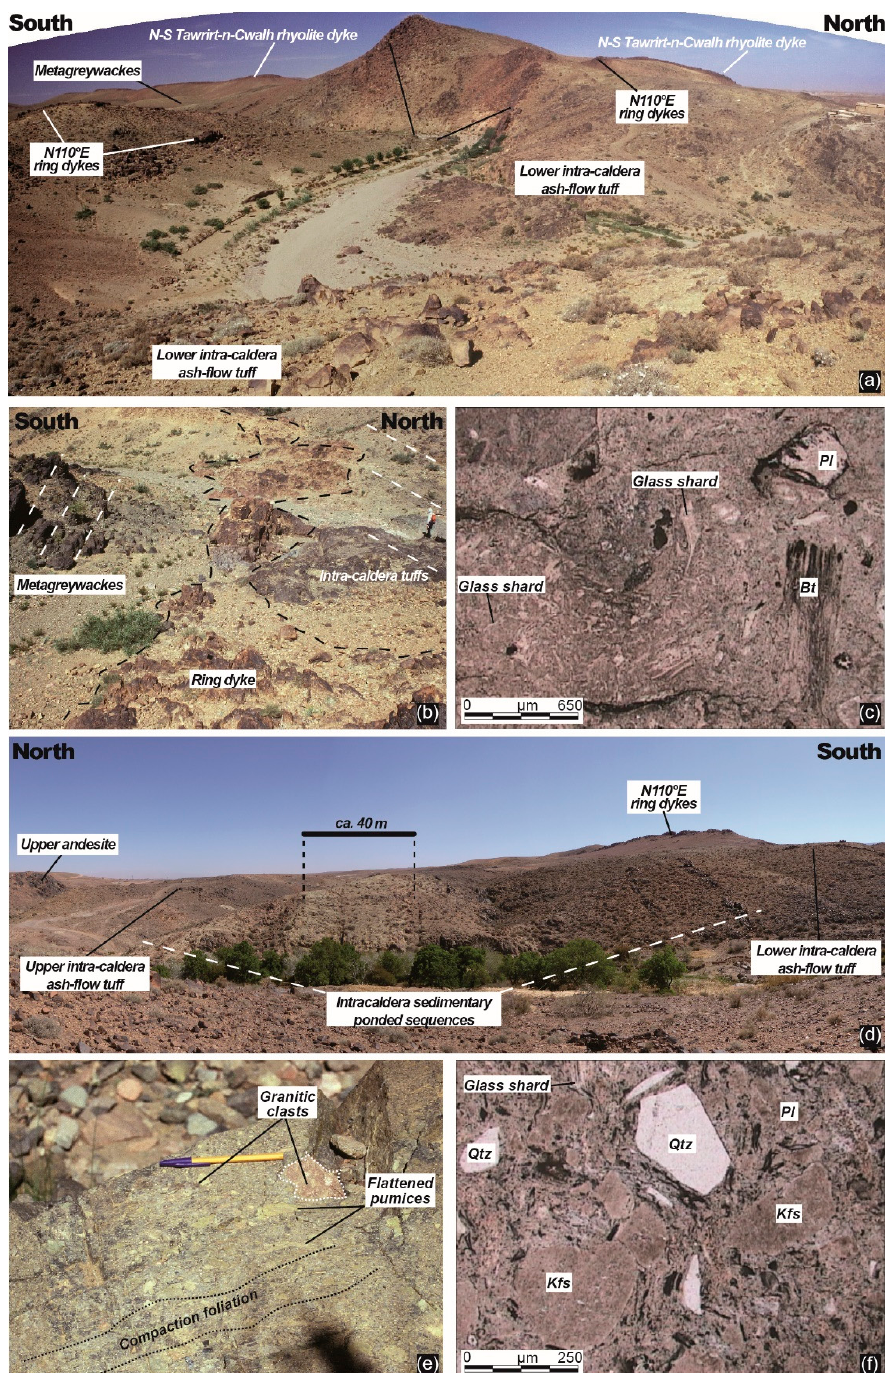
Figure 6. ( a ) View of the structural limit of the caldera showing the contact between the intra-caldera sequence, rhyolite ring dykes and basement, Taghia area (see location on Figure 5). ( b ) Detailed view of the structural limit showing the ring dykes and the unconformity between the basement to the south and the intra-caldera sequences to the north. ( c ) Microphotograph of the lower intra-caldera ash-flow tuff. Slight compaction and welding of shards are characteristics of this tuff, Plane Polar Light. ( d ) View towards the east showing the relationships between the lower and upper intra-caldera tuffs and interbedded sedimentary ponded rock sequences Taghia area (see location on Figure 5). ( e ) Close-up view of the upper intra-caldera tuff characterised by compacted fiammes (flattened pumices) and lithic fragments of K-feldspar-rich granite. ( f ) In thin section, the upper ignimbrite shows strong compaction and welding of shards, Plane Polar Light. Bt: biotite, Kfs: K-feldspar, Pl: plagioclase, Qtz: